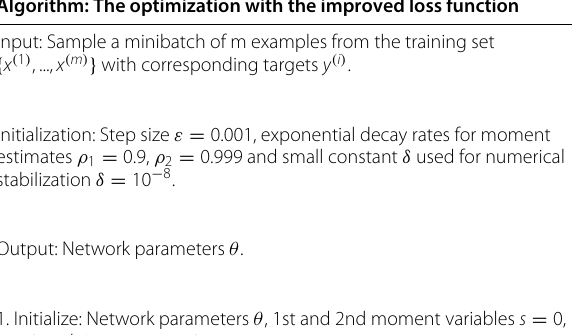
Algorithm: The optimization with the improved loss